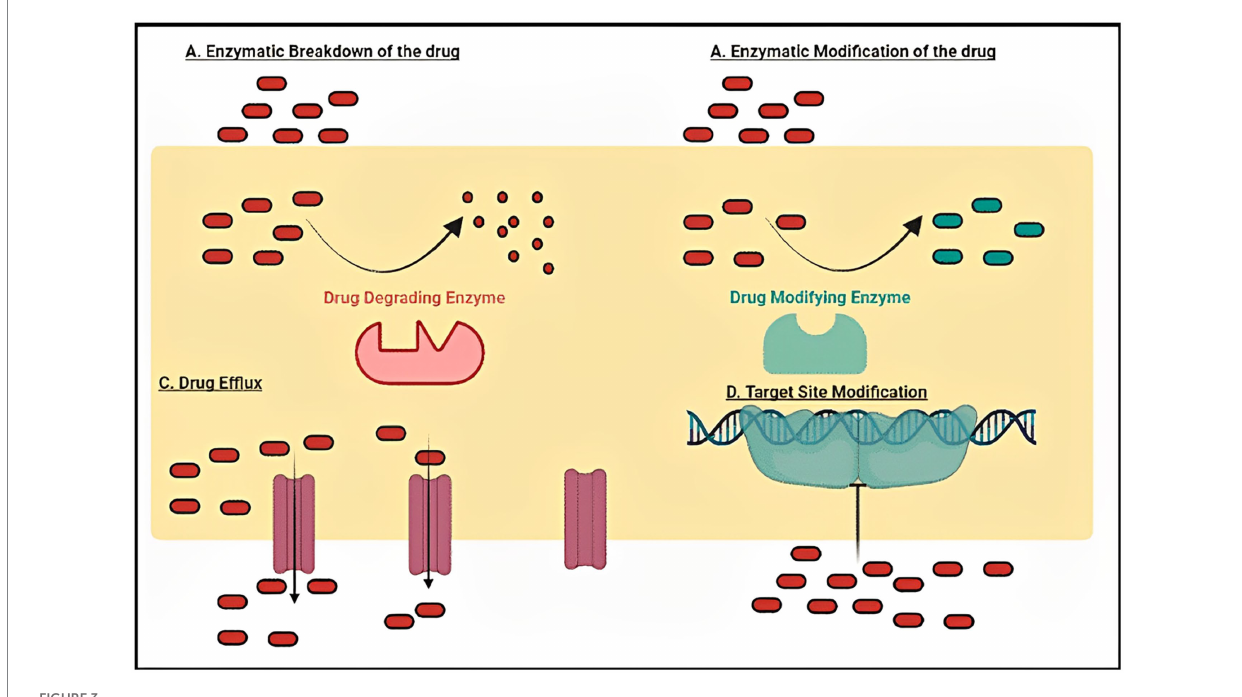
FIGURE 3 Drug resistance mechanisms like enzymatic degradation of drugs, modification of the drug target, activation of active efflux pumps and other associated drug tolerance processes/mechanisms adopted by various human microbial pathogens (Bacterial and Fungal) to tackle the effect of different antimicrobial